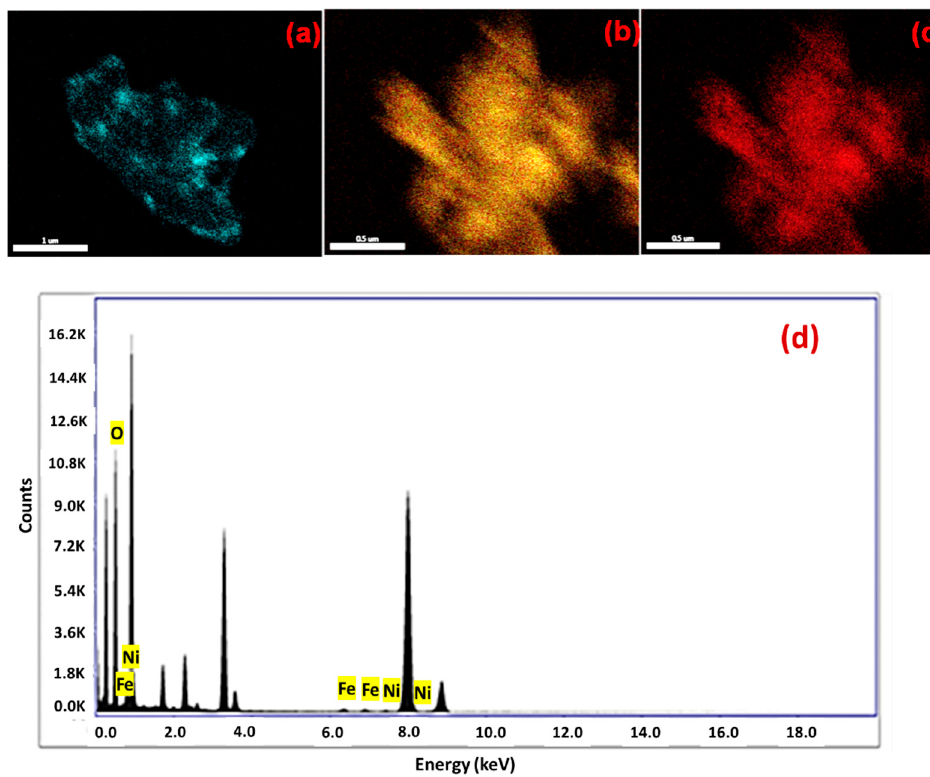
Figure 5. ( a ) Ni, ( b ) Fe, and ( c ) O HR-TEM elemental mapping and ( d ) EDAX spectrum of NiFe-LDH on TC.